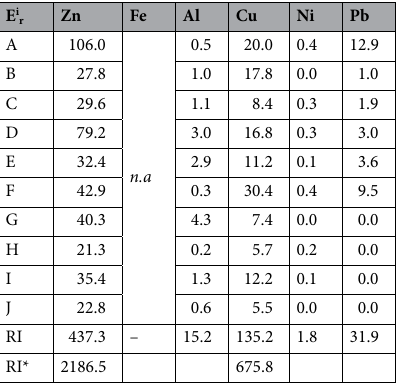
(Table 4). The comprehensive potential ecological risk index concurs with the single factor ecological risk, mild for Al, Ni and Pb, moderate for Cu and strong for Zn. It is important to emphasize that in terms of carcinogenic risk, both Cu and Zn showed a high risk index. The zones that have been urbanized for long periods (1984–1996) display higher contamination levels (4 and 3) than more recently urbanized zones (2001–2019), which have lower degrees of contamination. Additionally, the nonmetric multidimensional scaling (MDS) ordination depicted the grouping of sinkholes based on the concentration of heavy metals (Fig. 6). We noticed that sites A and F are separated from the rest because of the